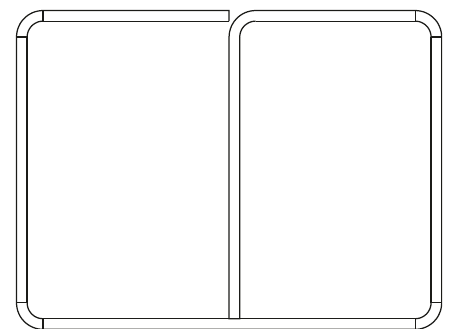
Figure 3: Schematic diagram of the “ 日 ” cross section.